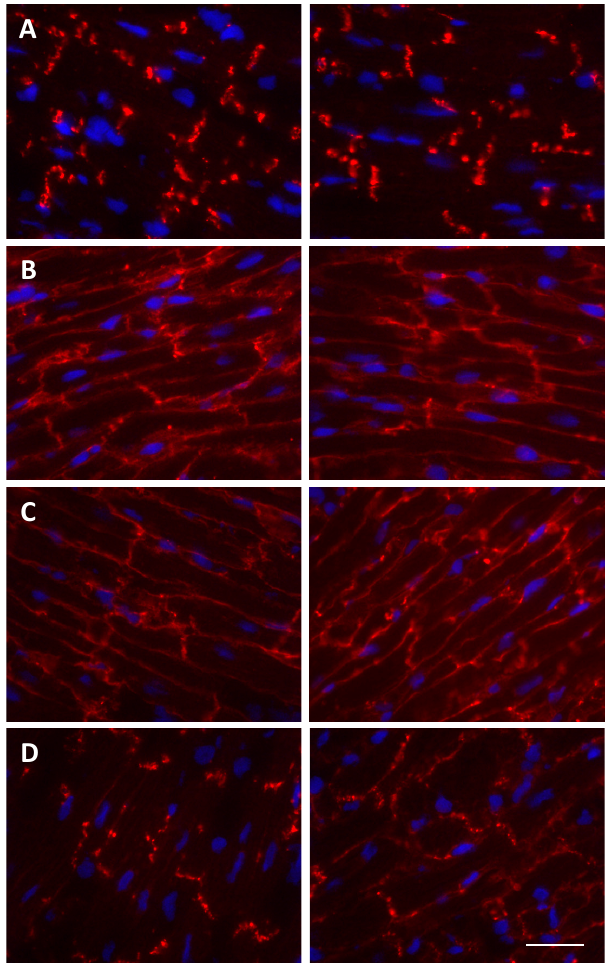
Figure 4. Cx43 immunofluorescent staining (in red) in Langendorff-perfused hearts subjected to ex vivo I / R. ( A ) End of stabilization period. ( B ) After 30 min of global no-flow ischemia. ( C ) After 30 min of global no-flow ischemia and 5 min reperfusion. ( D ) After 30 min of global no-flow ischemia and 60 min reperfusion. Nuclei are stained with 4’,6’-diamidino-2-phenylindole (DAPI) (in blue). Scale bar represents 20 μ m.